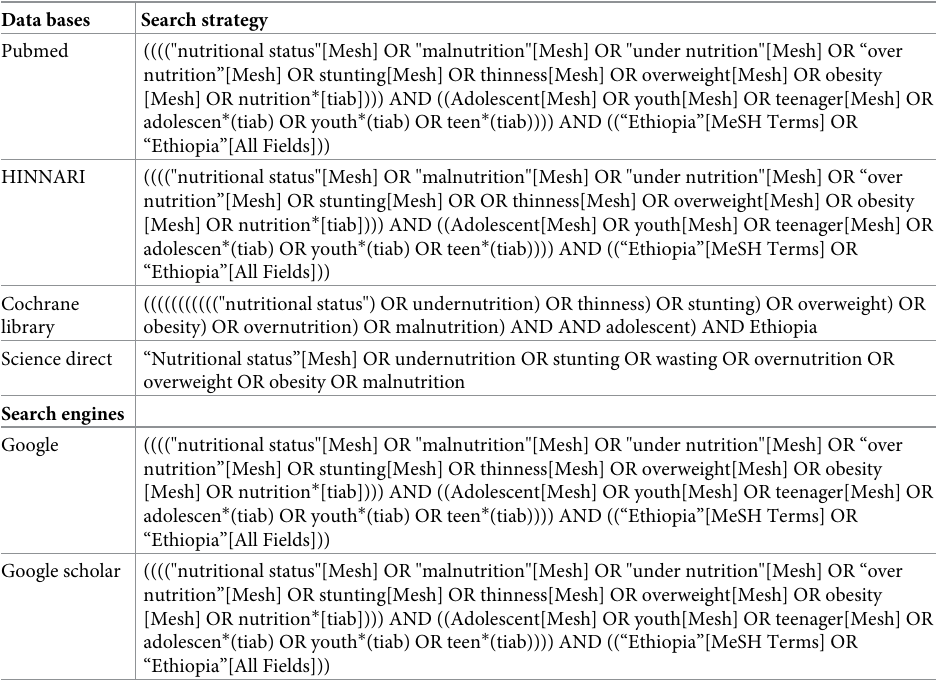
Table 1. Search strategies of adolescent malnutrition and associated factors in